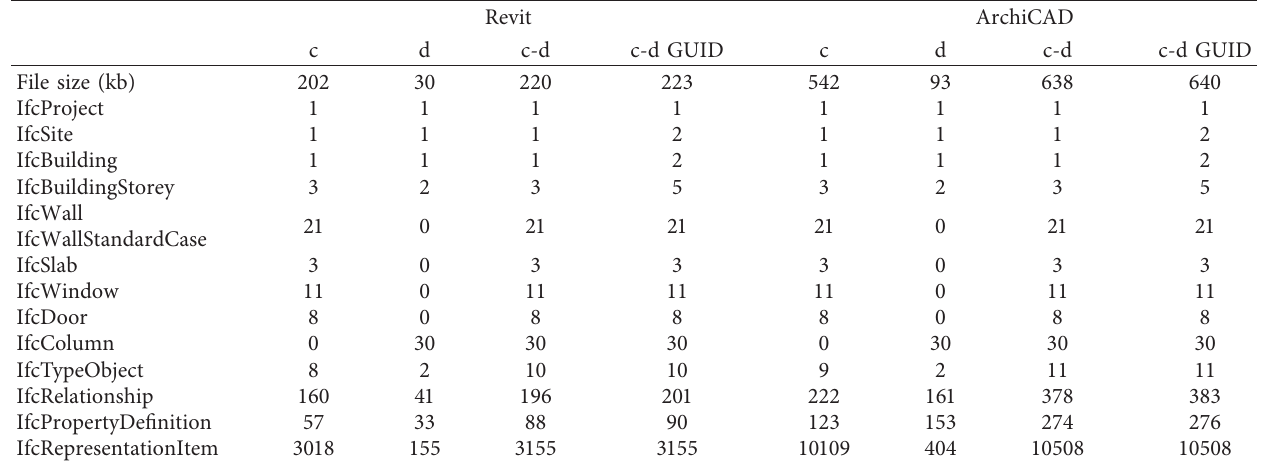
Table 2: Entity statistics for scenarios c and